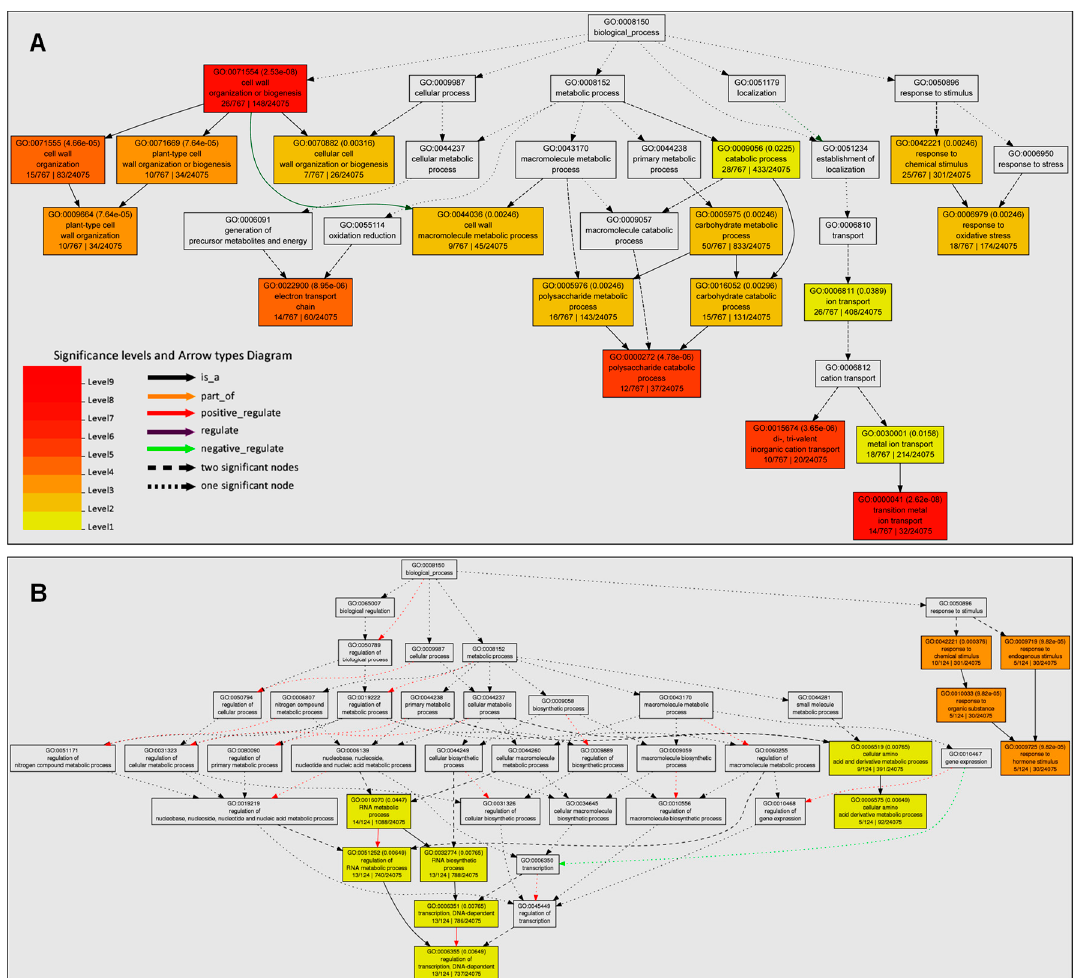
Figure 3. Gene ontology (GO) enrichment analysis of DEGs in the biological process GO term using AgriGO v2. ( A ) GO enrichment analysis of up-regulated DEGs. ( B ) GO enrichment analysis of down-regulated DEGs. Singular enrichment analysis (SEA) was performed in AgriGO v2 in order to identify the enriched GO terms for up-regulated or down-regulated genes. Each box shows the GO term number, the p -value, and GO term. The box color indicates the level of statistical